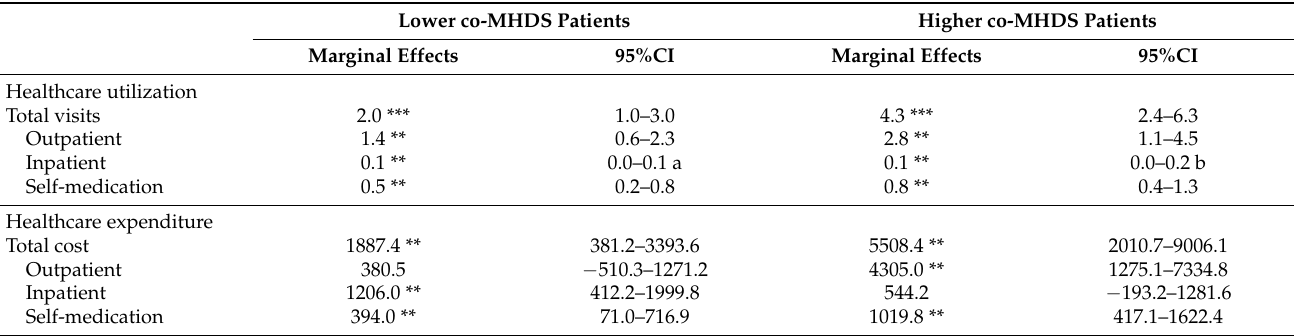
Table 2. Additional healthcare utilization and expenditure of depressive symptoms among middle-aged and elderly people with hypertension.